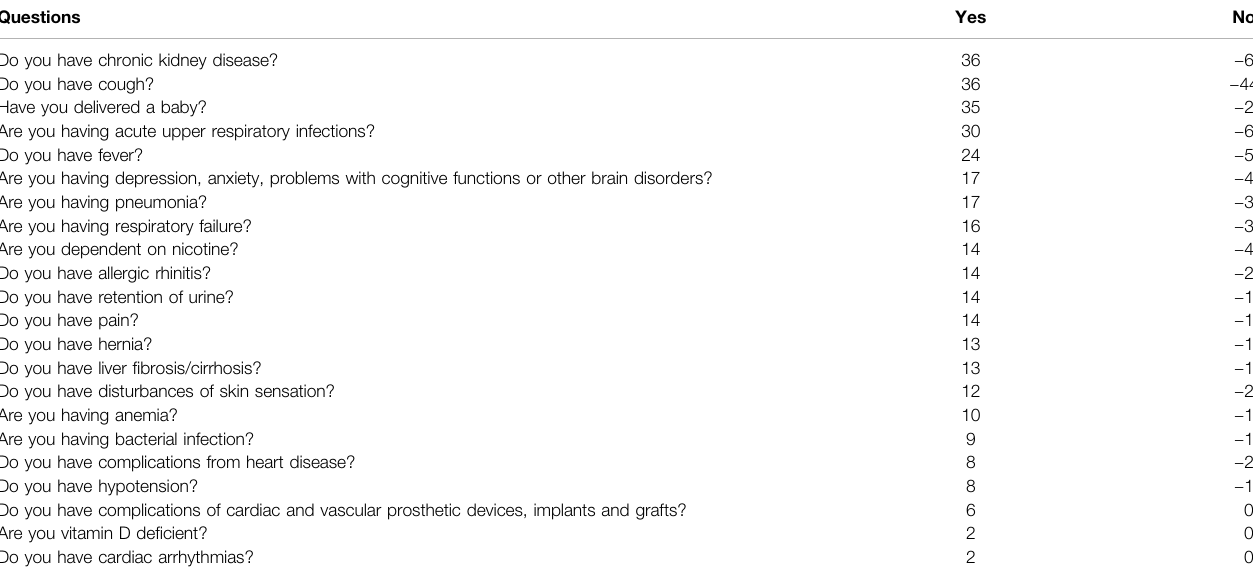
TABLE 3 | Example questionnaire Example questionnaire built using our selected model using the UAB-i2b2 data — the LASSO method on the 2-week fi ltered data. Base score is 320 and the risk increases/decreases based on the answers in the questionnaire. Any score between 450 and 696 is considered high risk for infection. Disclaimer: This questionnaire is intended only as an example output from a model built using our pipeline. It is not itself a diagnostic